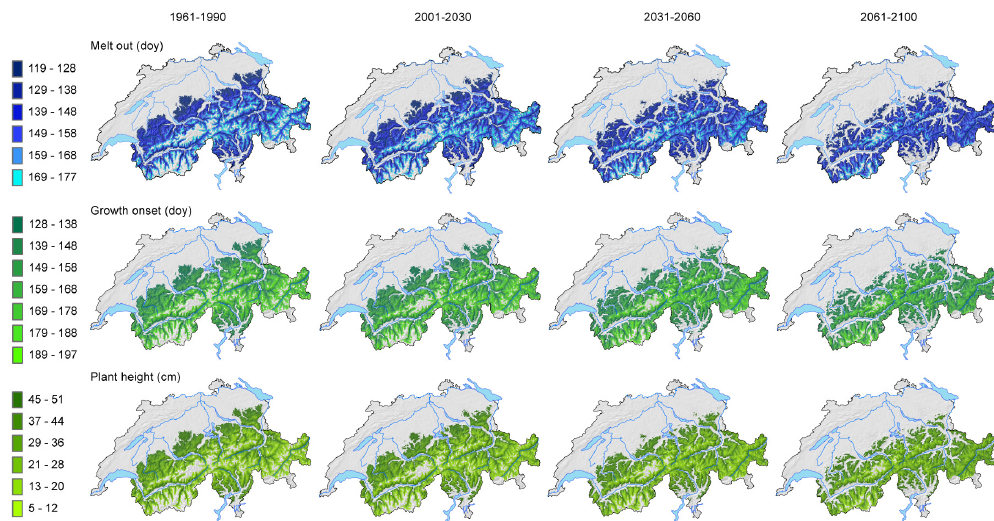
Figure 5 Fig. 5. Regional differences in melt out ( V M ), onset of growth ( V G ), and plant height ( V P ) as projected from mean May/June temperature from high resolution climate data ( T sim high ). Dark colours indicate early melt out, early onset of growth and highest plant heights. The results are shown for the HadCM3-A2 scenario for the period 1961–1990, 2001–2030, 2031–2060 and 2061–2100. Only grid cells within the four selected biogeographic regions (Fig. 1) with an altitude of > 1500ma.s.l. Note that for each time period, grid cells exceeding the observed temperature range were